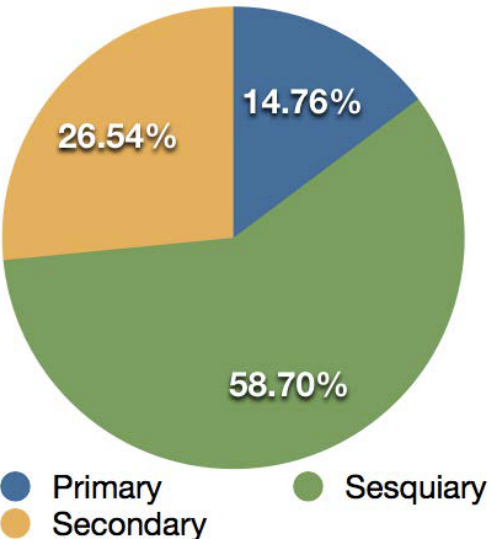
Figure 13. Tweet log